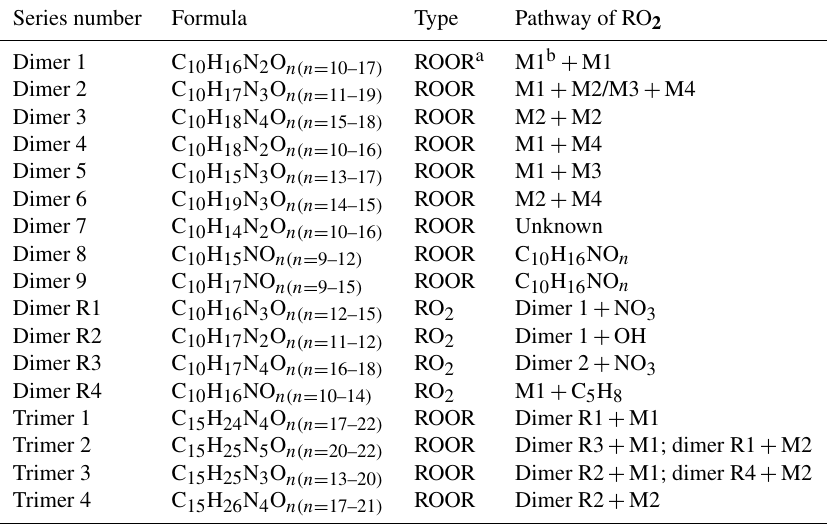
Table 2. HOM dimers and trimers formed in the oxidation of isoprene by NO 3 . Series number Formula Type Pathway of RO 2